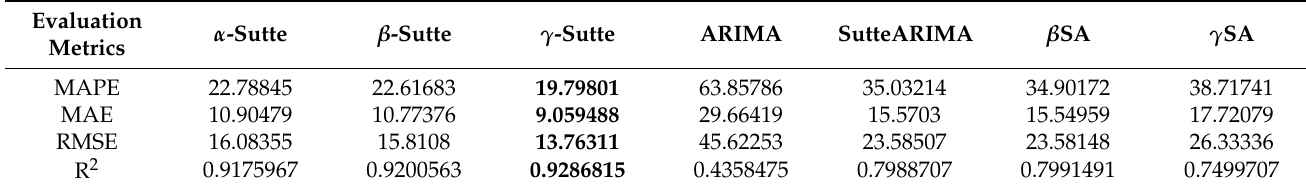
Table 6. Prediction results of time series model and ensemble model in the Vientiane